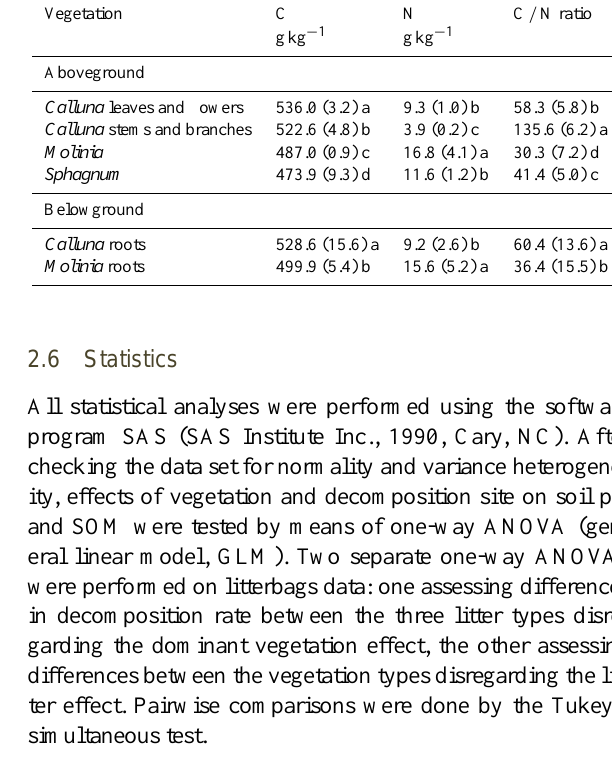
Table 1. Carbon and nitrogen concentrations and C / N ratio of the dominant plant species in the Storgama area. Values in parentheses are standard deviations of six independent replicates. Lower-case letters indicate significant differences ( p < 0.05), with above- and belowground vegetation treated